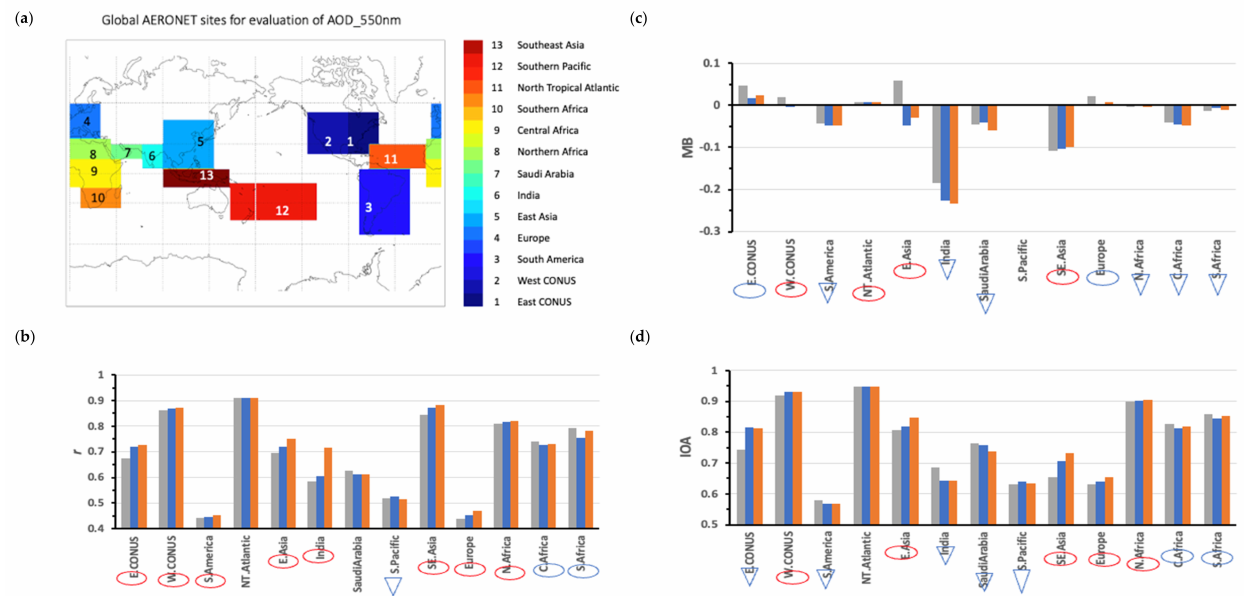
Figure 10. ( a ) Thirteen regions for the evaluation of SO 2 emissions. ( b ) The correlation, ( c ) MB, and ( d ) IOA. Gray, blue, and orange bars indicate BASE , SENS1 , and SENS2, respectively . Red circles over the region names indicate that SENS2 improved relative to SENS1 . Inverted triangles indicate SENS2 deteriorated relative to SENS1 . Additionally, blue circles indicate that SENS2 improved relative to SENS1 ; however, SENS2 deteriorated relative to BASE